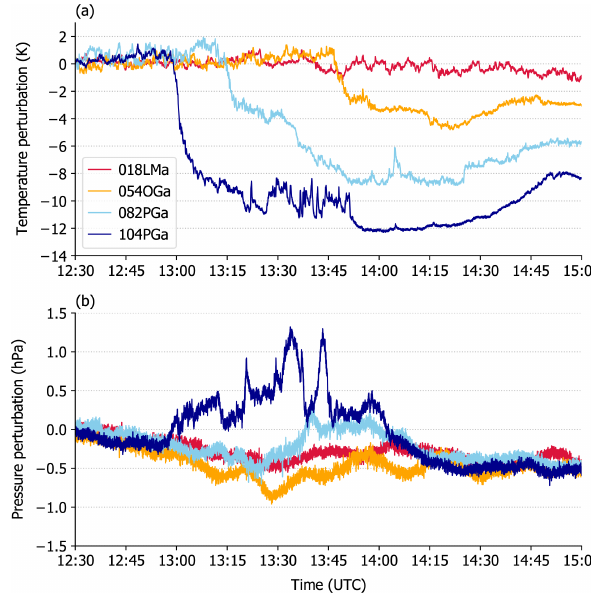
Figure 10. Perturbation in (a) air temperature and (b) pres- sure since 12:30UTC observed by the four selected APOLLO stations Luftmessnetz Habichtstraße (018LMa), Obsthof Lehm- beck (054OGa), Ochsenwerder Norderdeich (082PGa), and Luxweg (104PGa) during a cold pool event on 10 August 2020. Locations of the stations are highlighted in Fig.